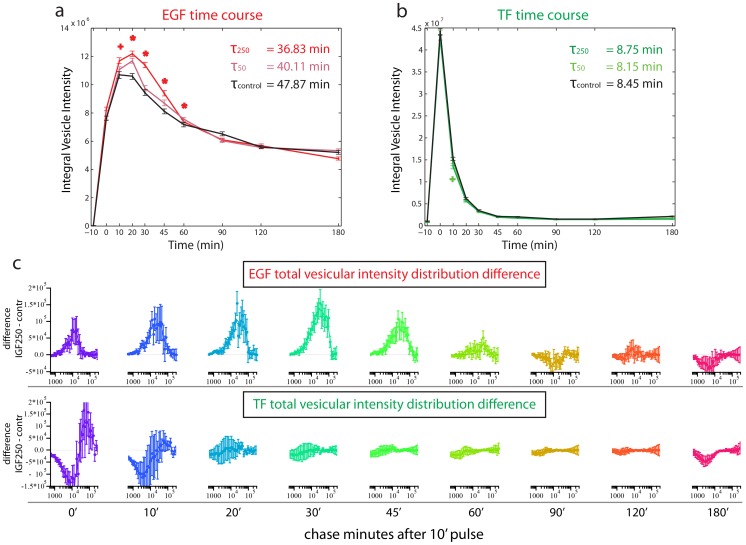
IGF-1 co-stimulation experiments.Pulse-chase experiment of labeled EGF and transferrin in presence of IGF-1. The 10 minutes pulse lasts from time point −10′ to 0′. (a) Temporal profile of the total vesicular intensity calculated for the EGF-positive endosomes, with different concentration of IGF-1 (dark red: 250 ng/ml; light red: 50 ng/ml; black: no IGF-1 (0 ng/ml), or control). (b) Temporal profile of the total vesicular intensity calculated for the TF-positive endosomes, with different concentration of IGF-1 (dark green: 250 ng/ml; light green: 50 ng/ml; black: no IGF-1 (0 ng/ml), or control). The insets within panels (a) and (b) show the estimated time constants obtained by fitting a decaying exponential function to the last part of each curve, for the corresponding concentrations (see Figure S11 for details). Asterisks (*) and plus sign (+) above individual time points indicate significant deviation from the control assessed by t-test (p≤0.0001 and p≤0.01, respectively). (c) Time course analysis for different chasing times: each mini-plot represents the difference of distributions (y-axis) of the total cargo content in endosome sub-populations of different mean content (bins in the x-axis) for EGF-positive endosomes (upper row) or TF-positive endosomes (lower row). All mini-plots show the difference between the distribution of the IGF-1-stimulated case (250 ng/ml, IGF250 in the label) and the control (contr in the label) for the corresponding time point and cargos. See Figure S9 and S10 for more details.